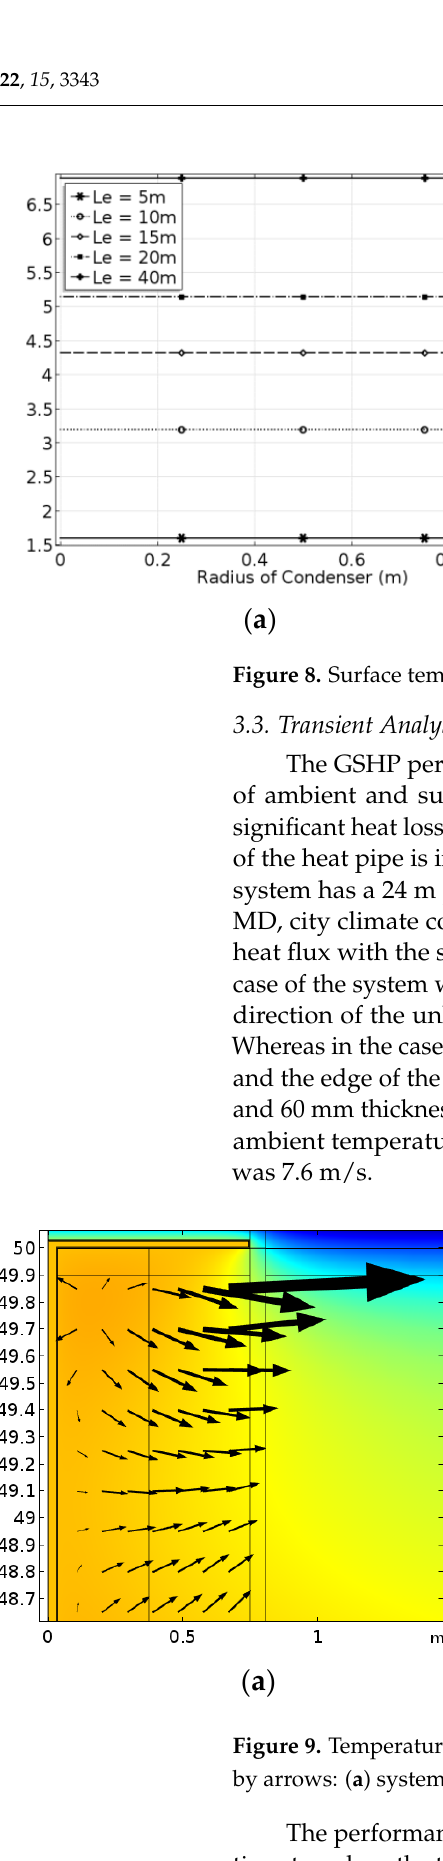
Figure 7. Parametric study for ( a ) evaporator length ( Le ) ( b ) Condenser radius ( Wc ).